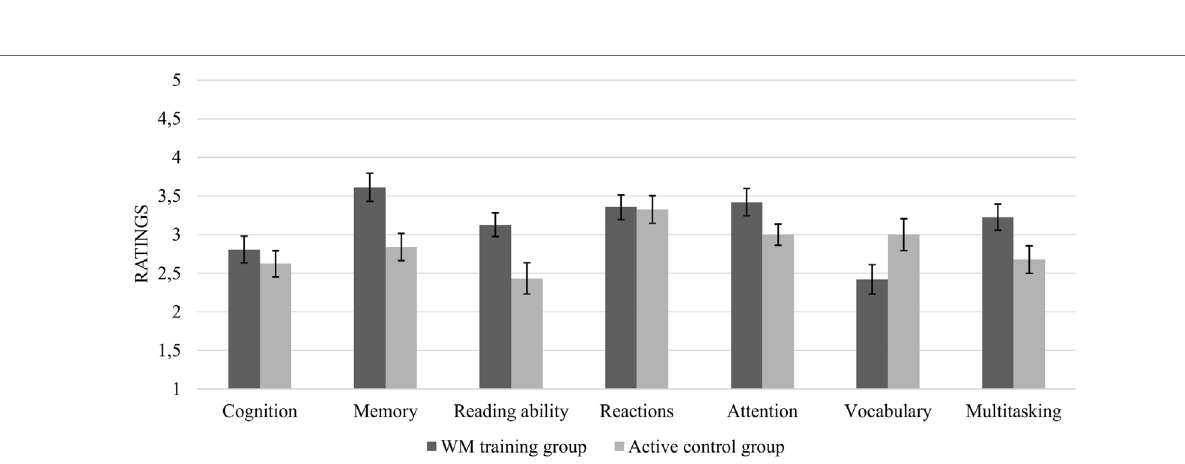
FigUre 5 | Perceived improvements on specific tasks at posttest in the two groups. Error bars represent SEMs. AWM, Alphabet working memory task; M2Span, Minus 2 span; OSpan, Operation span; Para_Rec, Paragraph recall; RSpan, Reading span; SR_Eng, Sentence recall in English; SR_Fin, Sentence recall in Finnish; SUS, selective updating of sentences; W_fluency, Word